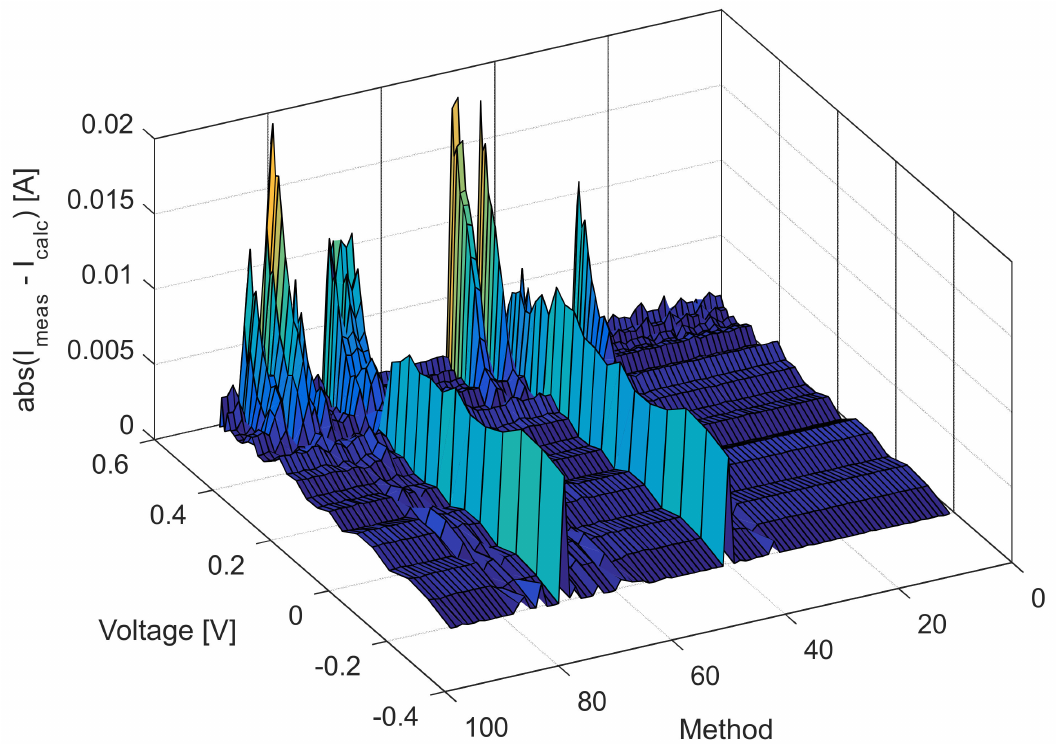
Figure 7. Difference between the measured and calculated current values for the methods listed in Table